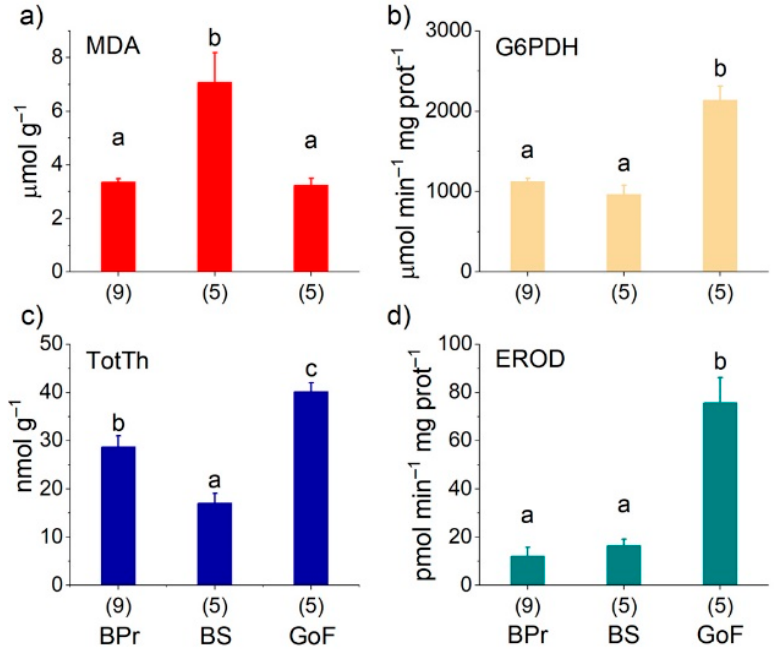
Figure 5. Mean ( ± SE) ( a ) malondialdehyde (MDA) concentration, ( b ) glucose 6-phosphate dehy- drogenase (G6PDH) activity, ( c ) total thiamine (TotTh) concentration, and ( d ) 7-ethoxyresorufin- O - deethylase (EROD) activity in the liver of salmon ( Salmo salar ) in the Baltic Proper (BPr), the Bothnian Sea (BS), and the Gulf of Finland (GoF) in the late fall. Different letters denote statistically significant ( p < 0.05) differences between the areas. The number of salmon is given in parentheses.